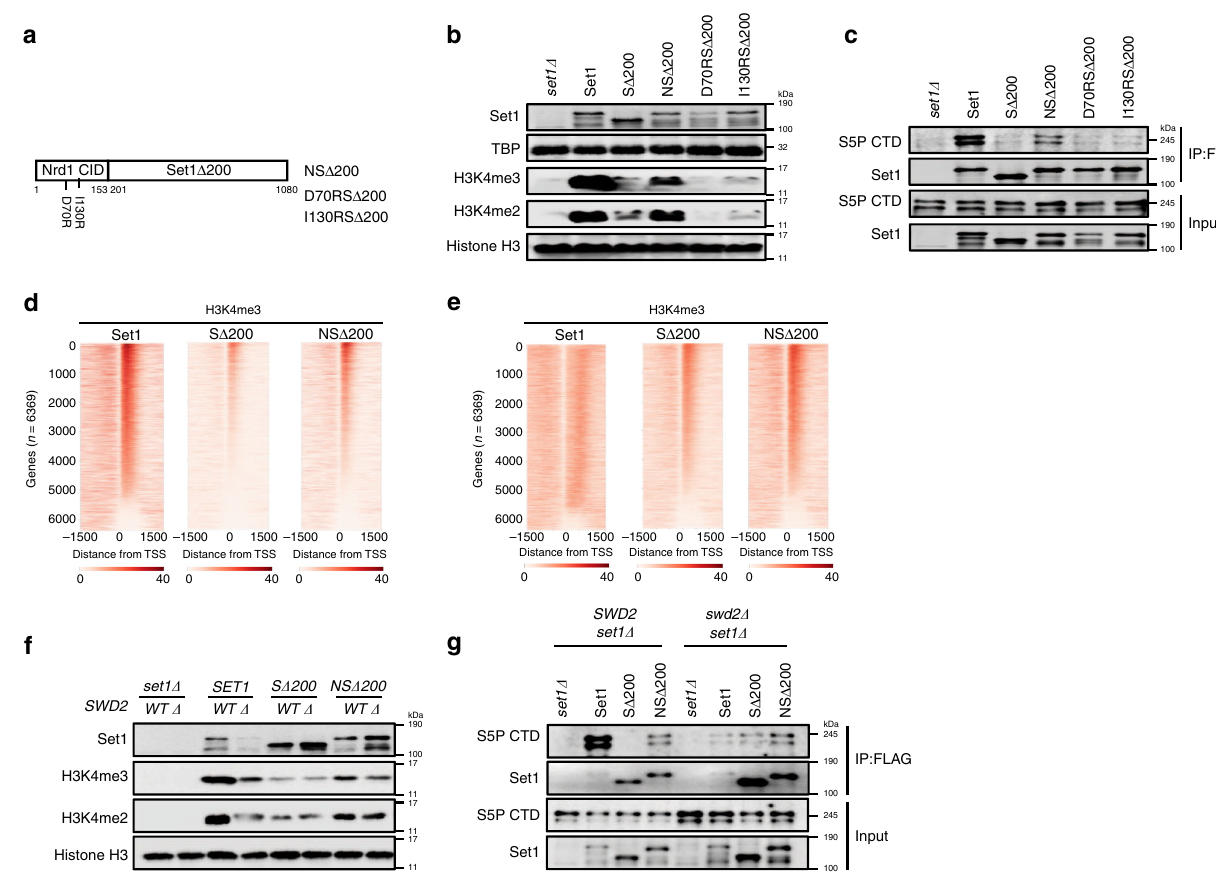
Fig. 4 Nrd1 CID fusion to Set1 Δ 200 partially restores CTD-binding and H3K4 methylation. a Schematic diagram of the NS Δ 200 fusion protein consisting of the Nrd1 CID (amino acids 1 – 153) and Set1 Δ 200. A FLAG-tag at the N-terminus is not shown. The positions of two CID mutants that disrupt CTD binding are also shown. b , c FLAG-tagged full-length Set1 (Set1), Set1 Δ 200 (S Δ 200), or Nrd1 CID fusions (NS Δ 200, D70RS Δ 200, and I130RS Δ 200) were transformed into set1 Δ cells. Whole-cell lysates ( b ) and proteins immunoprecipitated using anti-FLAG beads ( c ) were analyzed by immunoblotting using indicated antibodies. Cells transformed with empty plasmid ( set1 Δ ) served as a negative control. d , e ChIP-Seq heat maps of H3K4me3 ( d ) and H3K4me2 ( e ) from strains carrying full-length Set1 (Set1), Set1 Δ 200 (S Δ 200), or Nrd1CID – Set1 Δ 200 fusion (NS Δ 200). After normalizing to an internal spiked-in sample of S. pombe chromatin, SPMR values were mapped for individual RNApII transcriptional units and ordered according to H3K4me3 values in Set1 cells. H3K4me levels within 1500 bps from transcription start site (TSS) are shown. ChIP-seq reads from two technical repeats were averaged and plotted. f , g FLAG-tagged full-length Set1 (Set1), Set1 Δ 200 (S Δ 200), and Nrd1CID – Set1 Δ 200 (NS Δ 200) were transformed into set1 Δ or set1 Δ swd2 Δ cells. f Whole-cell lysates or g anti-FLAG immunoprecipitates were separated by SDS-PAGE and analyzed by immunoblotting using the indicated antibodies. Histone H3 was used as a loading control. Source data are provided as a Source data fi